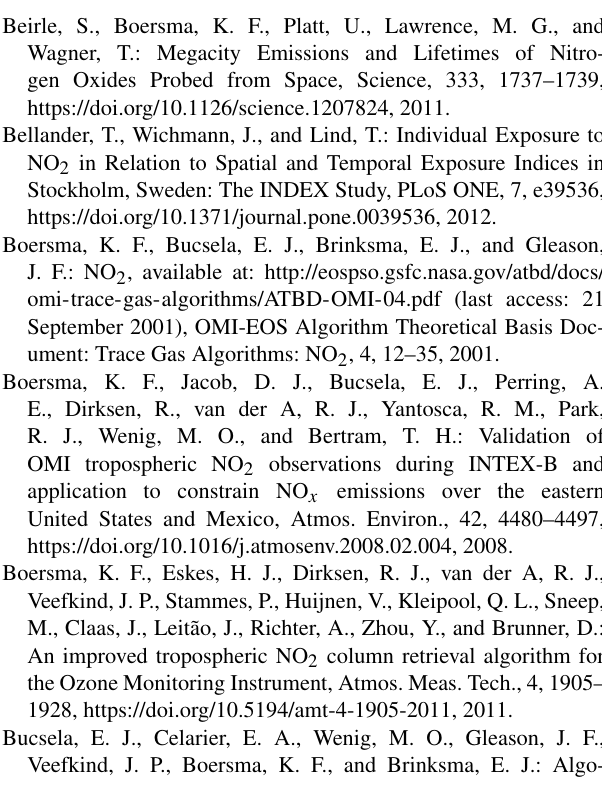
Figure 10. Seasonal, climatological average tropospheric NO 2 total column (a) based only on cloud-screened OMI data (2004–2015), NO 2 distribution during extreme events ( b ; also based on cloud- screened data) and the difference between the two (c) . The units are in moleculescm − 2 .